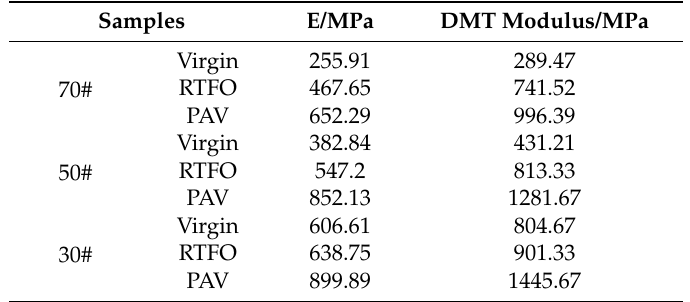
Table 9. Macro-compression modulus E of bitumen before and after aging tested at 6250 Hz.